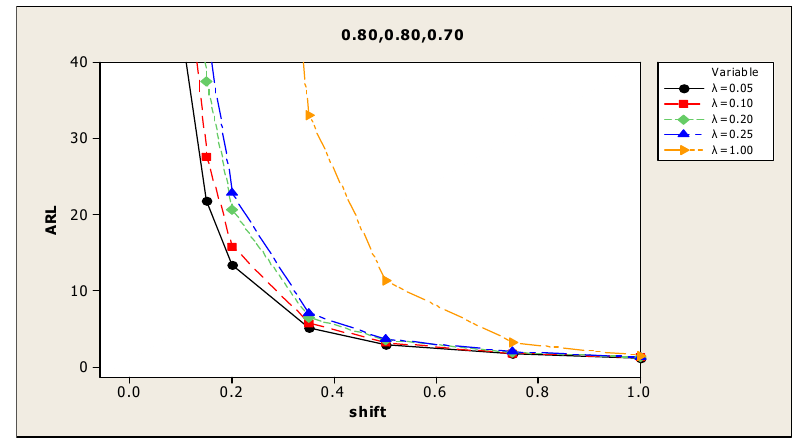
Figure 10. ARL curves when ρ yu = 0.8, ρ yv = 0.8, ρ uv = 0.7 at above values of λ .